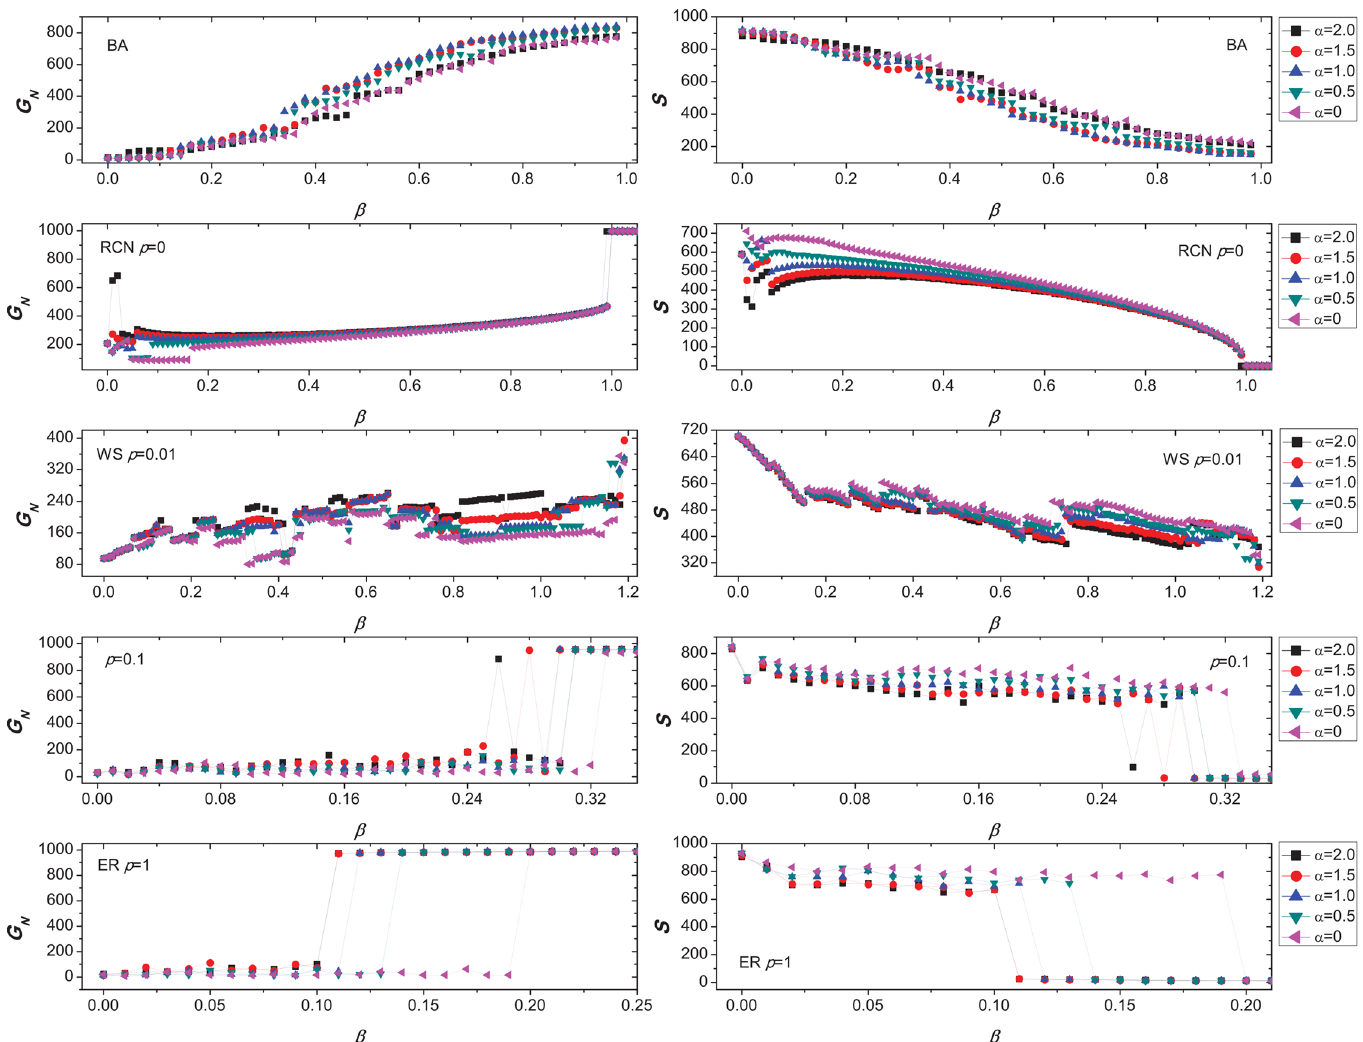
Fig 4. Dynamics of cascading failures in five synthetic networks, N = 1000, h k i = 4. (a) The scale-free networks were constructed by BA model [44] and data is averaged over 20 independent runs of node removal. (b) Ring-coupled network. (c) The WS small world network [45] created by a ring-coupled network with the rewiring p = 0.01. (d) Synthetic network constructed by a ring-coupled network with the rewiring p = 0.1. (e) Random network created by a ring-coupled network with the rewiring p = 1. (b-e) Data is from a single run. (a-e) We plot G and S as functions of the parameter β for five cases of α = 0, α = 0.5, α = 1, α = 1.5, and α =